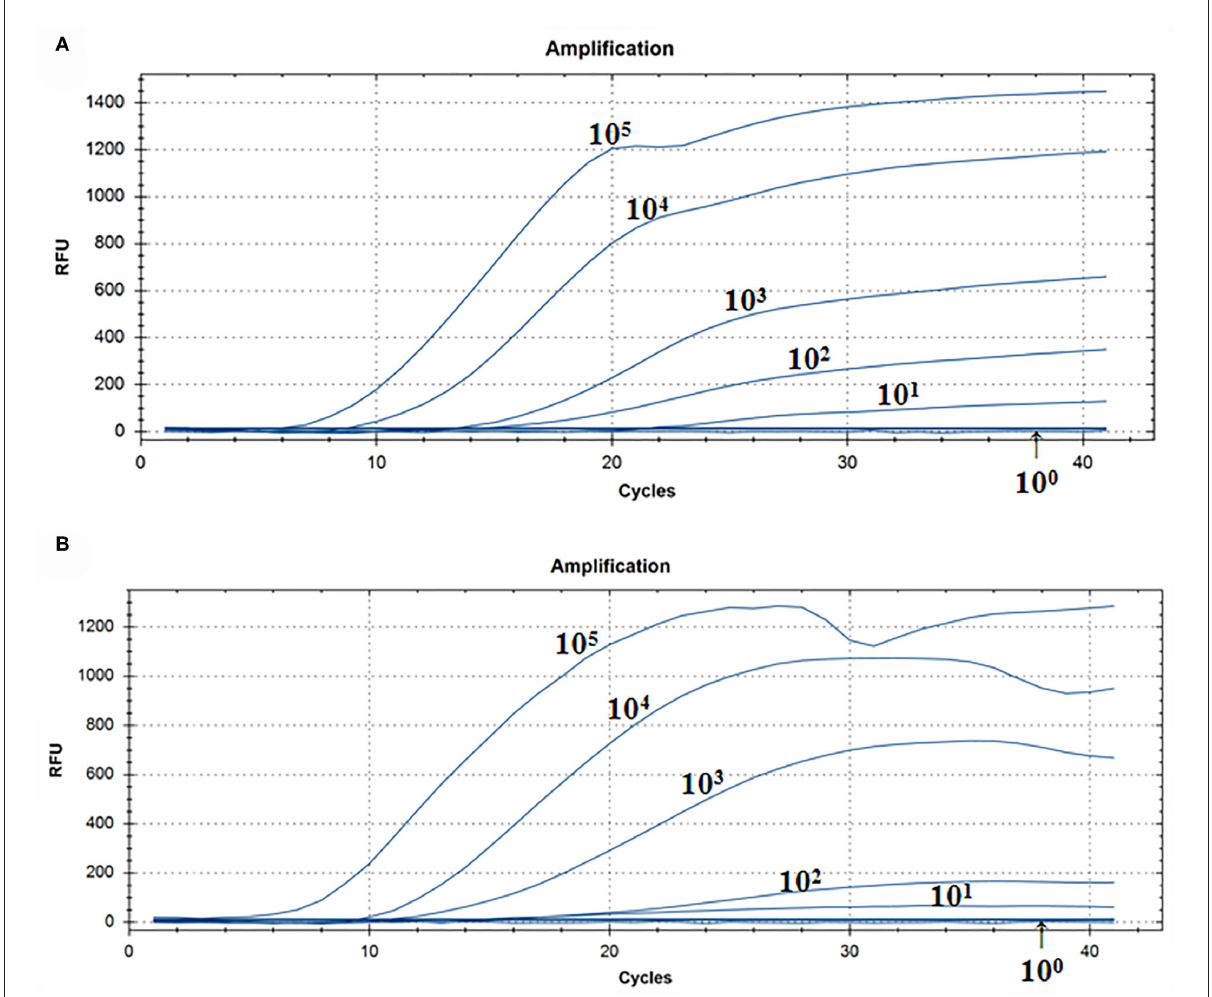
FIGURE3 Assay for the real-time RT-RAA sensitivity. (A) Pure standard plasmids were detected at 10 0 , 10 1 , 10 2 , 10 3 ,10 4 , and 10 5 copies/ µ l, respectively. (B) Complex plasmid solutions were detected at 10 0 , 10 1 , 10 2 , 10 3 ,10 4 , and 10 5 copies/ µ l, respectively. The real-time RAA can detect 10 copies per reaction in pure standard plasmids and complex plasmid